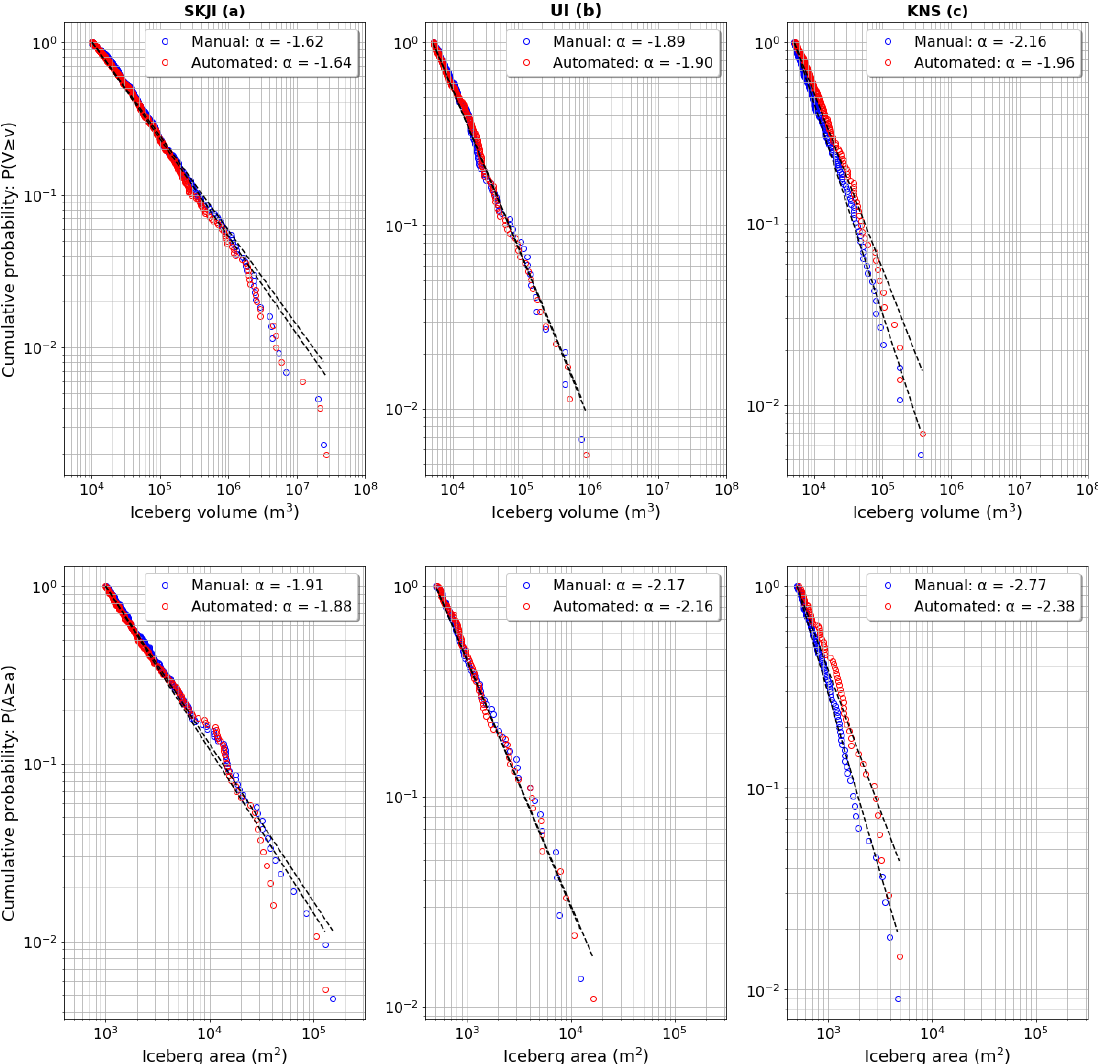
Figure 6. Power law plots for the manual (blue open circles) and automatically (red open circles) delineated icebergs. For iceberg area: (a) SKJI has an x min value defined at 1000m 2 , compared with 500m 2 for both (b) UI and (c) KNS. For defining an x min for iceberg volume distributions, the respective area x min value was converted using the equation of Sulak et al. (2017; their Eq. 5) yielding a value of 10270m 3 for SJKI and 5135m 3 for UI and KNS. The black lines show the line of best fit for the iceberg distributions. Note that the y axis is plotting cumulative probability where alpha equals −